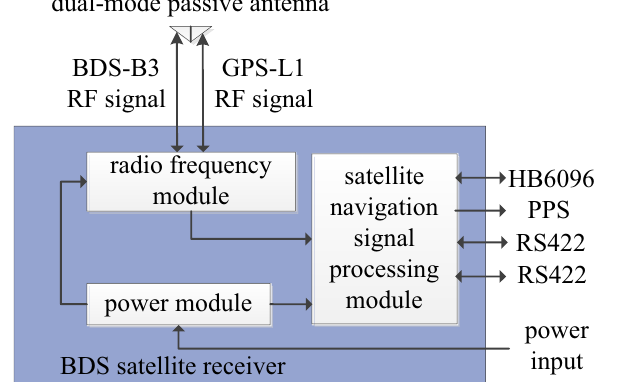
Figure 3. Diagram of the BDS satellite